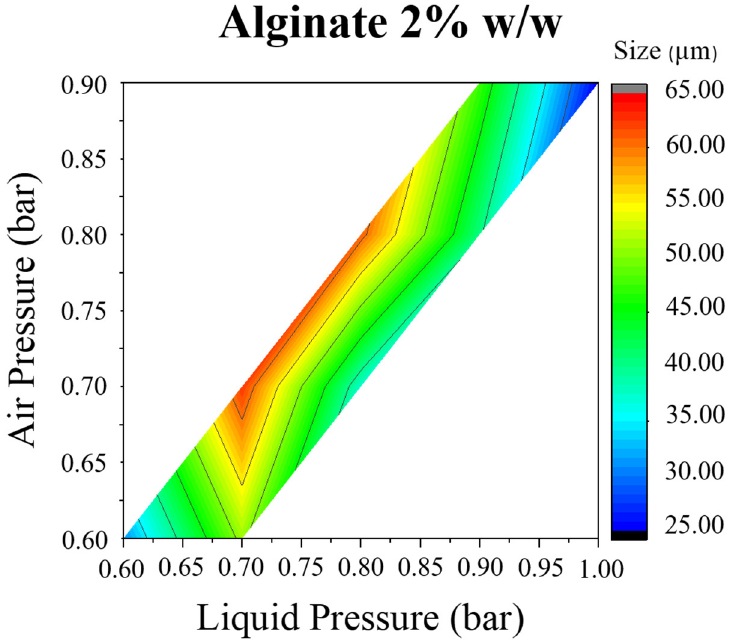
Figure 6. Alg-BaCl 2 MPs. Air and liquid pressure influence on particle size diameter for 2% w / w 2% w / w alginate.